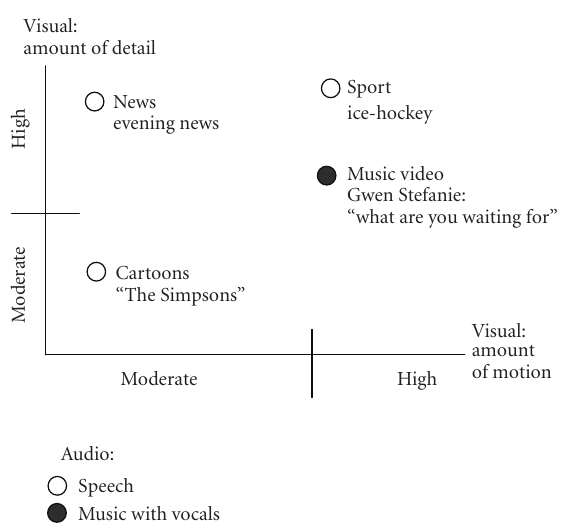
Figure 3: Genre of stimuli, contents, and their audiovisual charac-